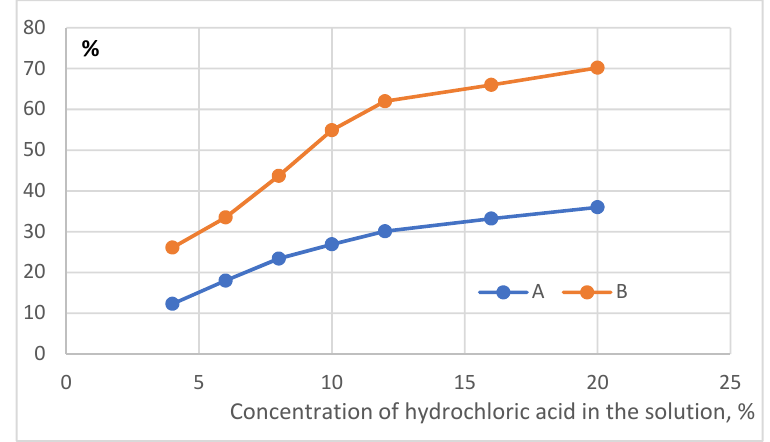
Figure 7. Average Aluminum extraction (%) without mechanical activation (A) and with mechanical activation (B).